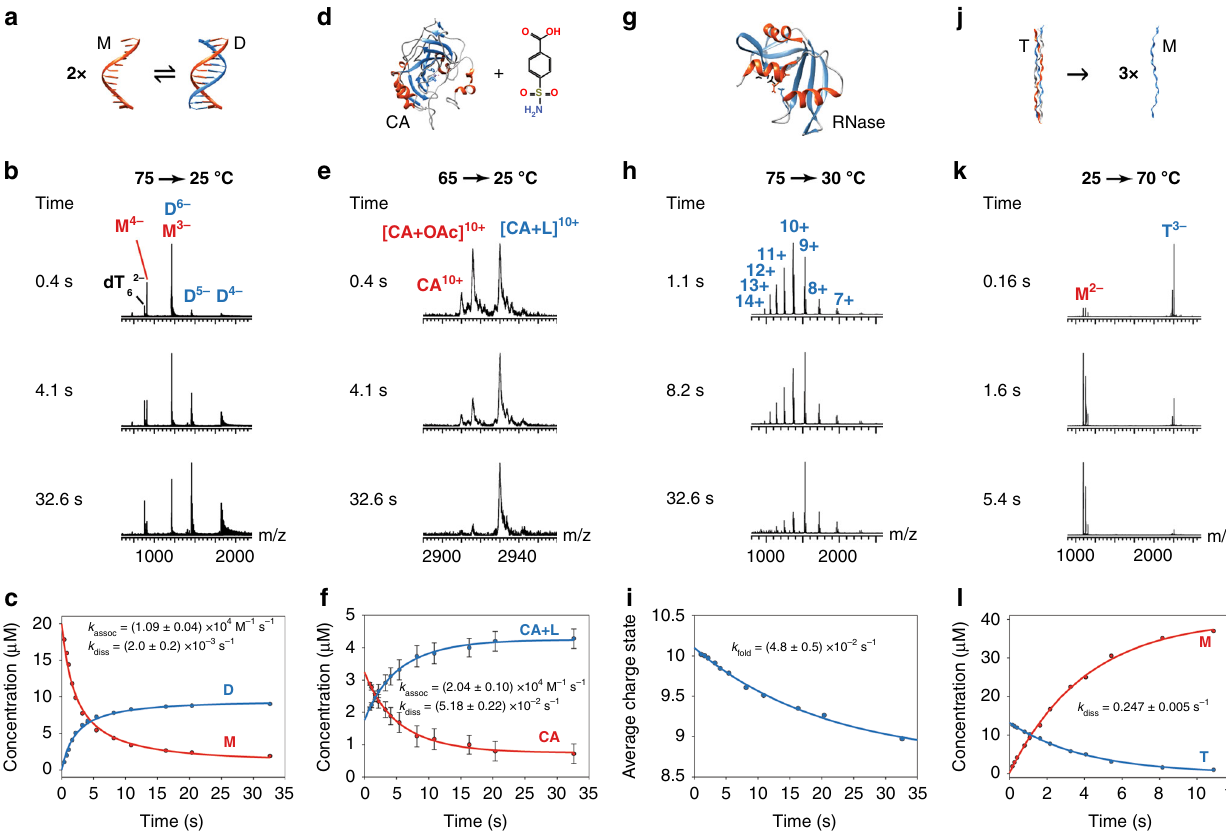
Fig. 3 Kinetics recorded using the temperature-jump source for exemplary biological systems. a – c the formation of a self-complementary DNA duplex (20 µ M d(CGT AAA TTT ACG) in 100 mM TMAA). M and D denote the mononer and duplex, respectively; d – f the binding of a ligand to a protein (5 µ M Carbonic Anhydrase II (PDB ID: 1CA2 50 ) with 5 µ M 4-carboxybenzene sulfonamide in 10 mM NH 4 OAc). CA and L denote Carbonic Anhydrase II and ligand, respectively; g – i the folding of a protein (10 µ M Ribonuclease A (PDB ID: 5RSA 80 ) in 100 mM NH 4 OAc at pH 2.75). RNase denotes Ribonuclease A; j – l the dissociation of a collagen peptide triple helix into monomers (40 µ M [POG] 8 collagen peptide (PDB ID: 1CGD 54 ) in 10 mM NH 4 OAc). M and T denote monomer and trimer, respectively. The vertical error bars in f are the standard deviation obtained from the quanti fi cation on different charge states (12 + , 11 + , 10 + , and 9 + , n = 4). The reproducibility of the experiment is discussed in the Discussion section. The errors on the rate constants are the standard deviations from the fi tting. Source data are provided as a Source Data fi